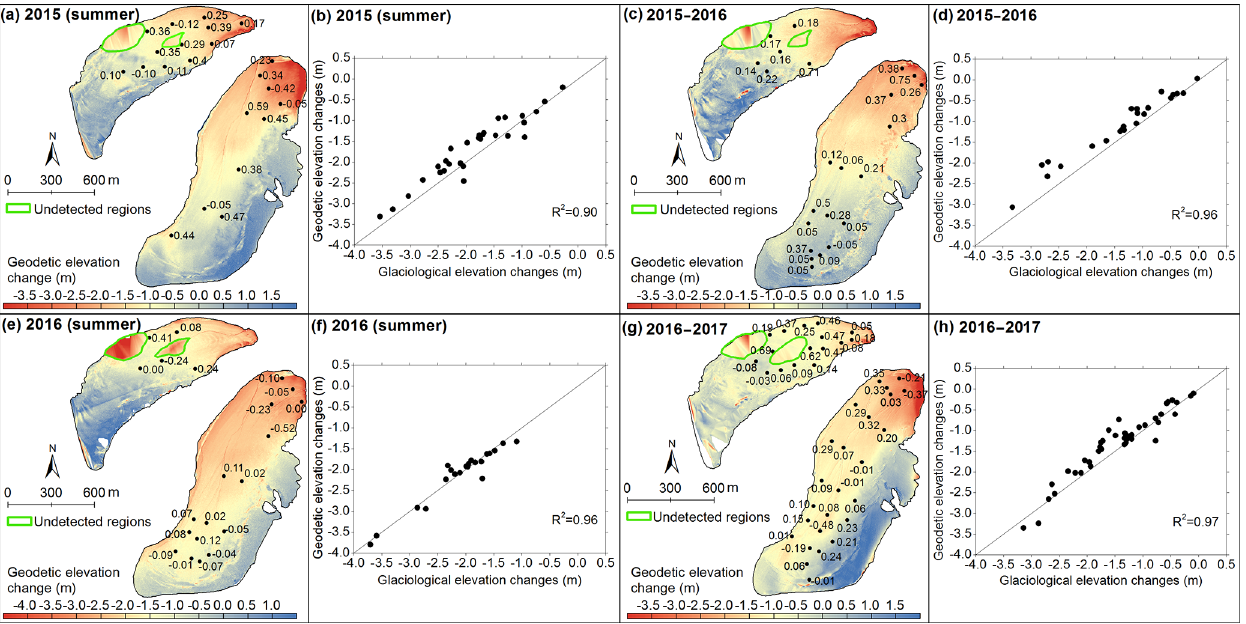
Figure 4. Spatial distribution of TLS-derived glacier surface elevation changes (a, c, e, g) ; the numbers represent the differences (m) between the TLS-derived ( (cid:49)h TLS ) and glaciological in-situ-measured ( (cid:49)h glac ) elevation changes at corresponding ablation stakes ( (cid:49)h TLS − (cid:49)h glac ). Scatter plots of glaciological elevation change against geodetic elevation change at corresponding ablation stakes are presented, and the quality of fittings in terms of R 2 is also presented (b, d, f, h) . Black lines are the TLS-derived glacier boundary of Urumqi Glacier No. 1; the boundaries in (a) and (c) are the same as boundary 2015 in Fig. 2a; boundaries in (e) and (g) are from boundary 2016 and 2017 in Fig. 2a, respectively. White areas indicate outliers, which have been removed. Two green polygons indicate areas that have not been detected by the TLS. Table 3. Glacier-wide mean of density conversion ( ρ ) and its uncertainty ( σ ρ ) (kgm − 3 ) as well as TLS-derived glacier surface elevation changes ( (cid:49)h TLS) (m). TLS-derived geodetic ( B geod ) and in-situ-measured glaciological ( B glac ) net mass balance at summer and annual scales are listed